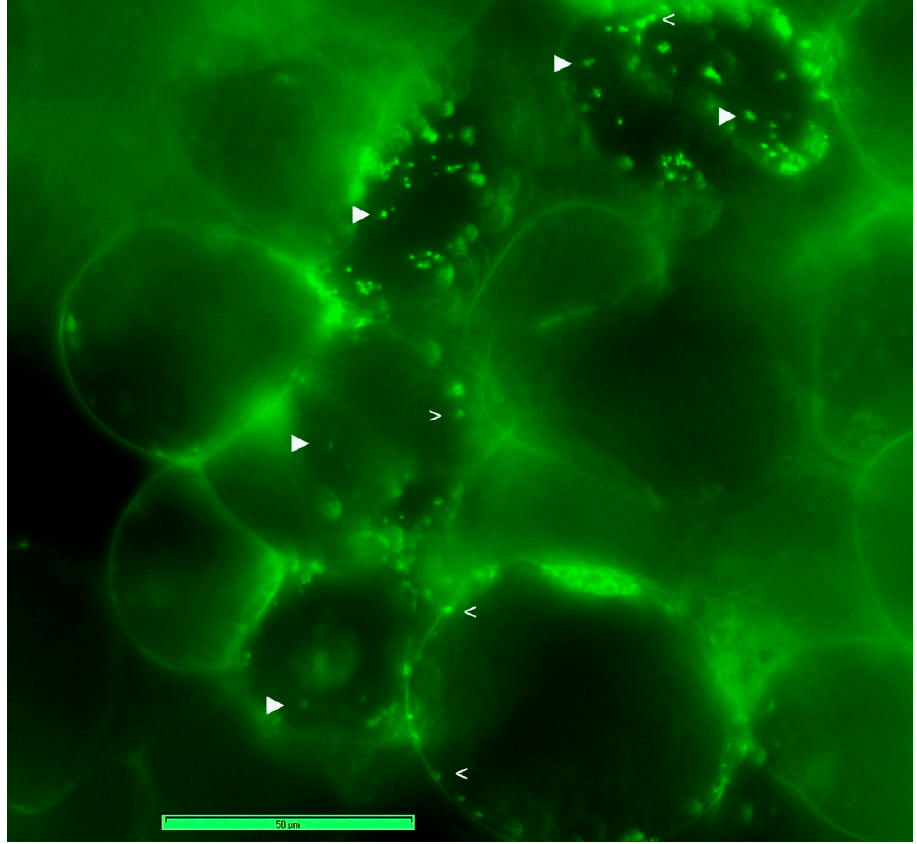
Figure 2. Epi-fluorescence microscopy on SYTO-9 stained grape cell culture after mild TritonX-100 permeabilization treatment (0.01%) for 30 min (40× objective). (Symbol ► indicates bacteria em-